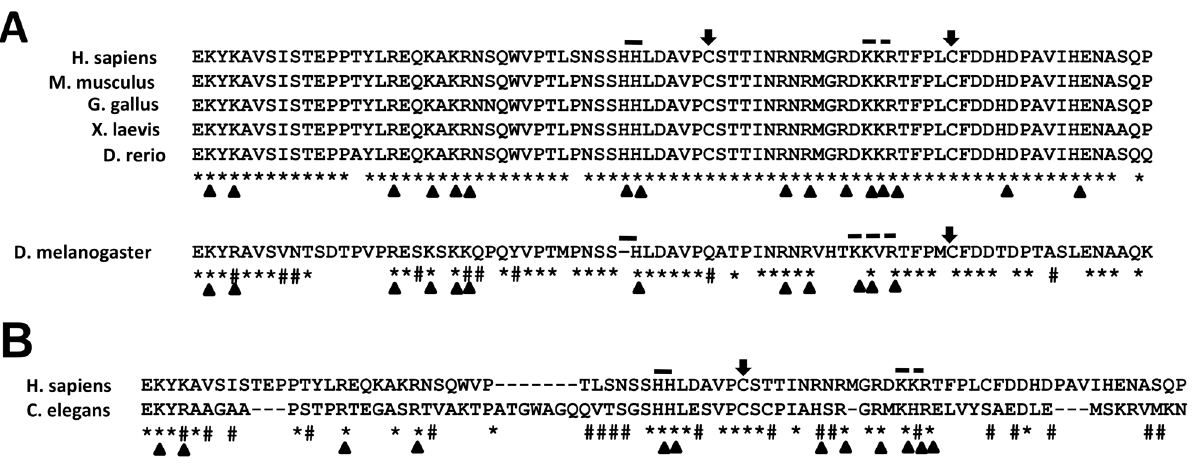
Figure 2. Sequence conservation of the putative DNA binding domain (DBD) of vertebrate INI1/hSNF5, Drosophila SNR1 and C. elegans SNF5. (A) Sequence comparison of the putative DNA binding domain of Drosophila SNR1 with the domains in vertebrates. Conserved residues are shown by (*) and partially conserved residues by ( # ). The HH and KKR motifs are shown with dash and broken dash, respectively. The conserved cysteine residues are shown by an arrow. The conserved lysine, arginine and histidine residues are shown with an arrowhead. (B) Sequence comparison of the putative DNA binding domain of C. elegans SNF5 with the human domain.